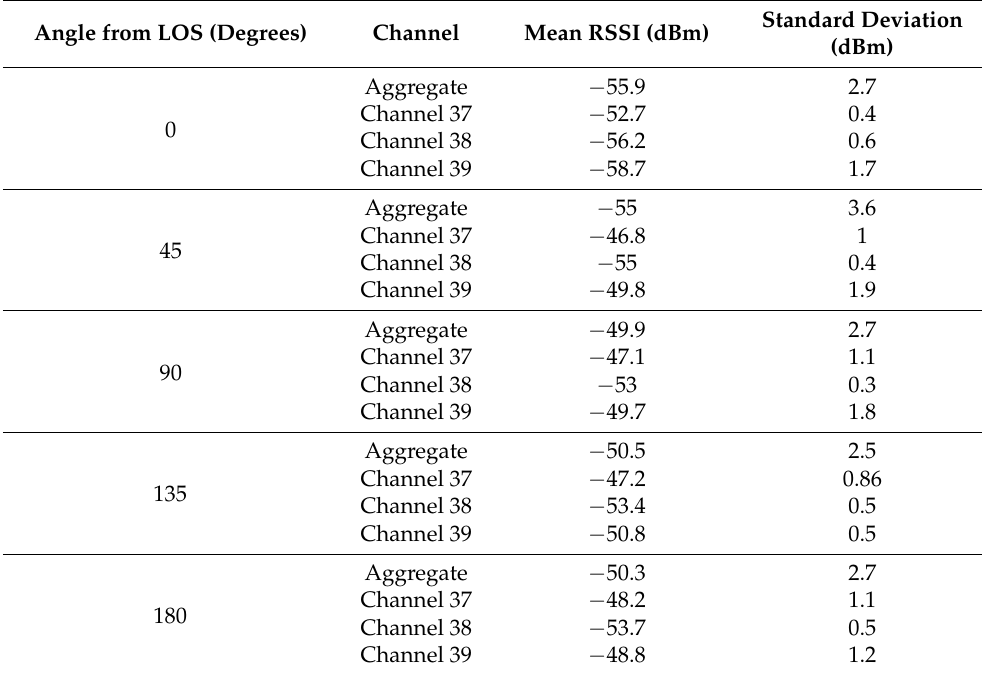
Table 1. Mean and standard deviation of the RSSI